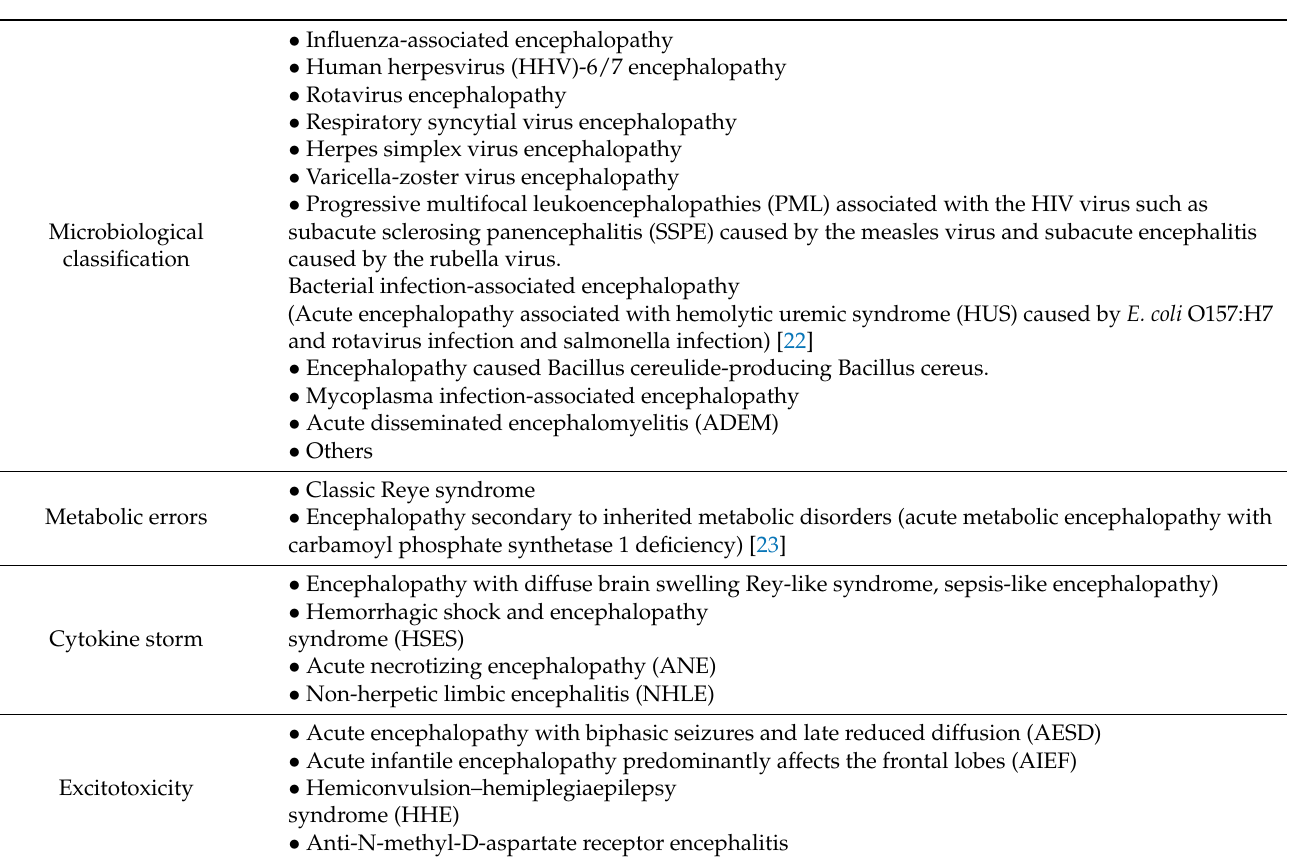
Table 1. Classification of Acute Encephalopathy